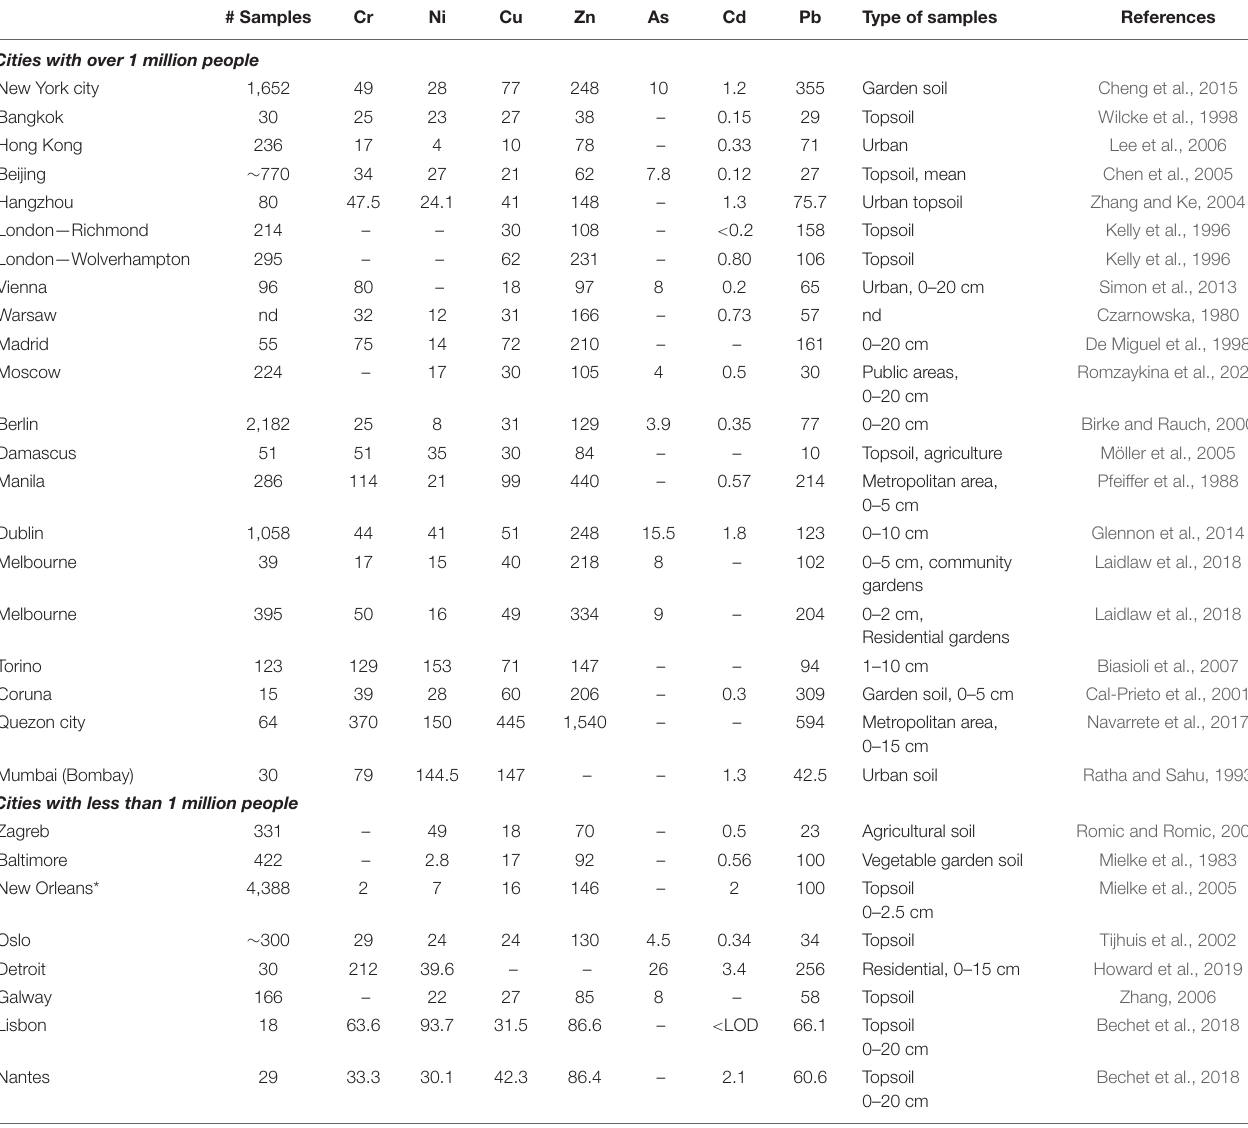
TABLE 1 | Comparison of mean trace elements concentrations in urban soils in selected cities around the world (in mg kg − 1 ). # Samples Cr Ni Cu Zn As Cd Pb